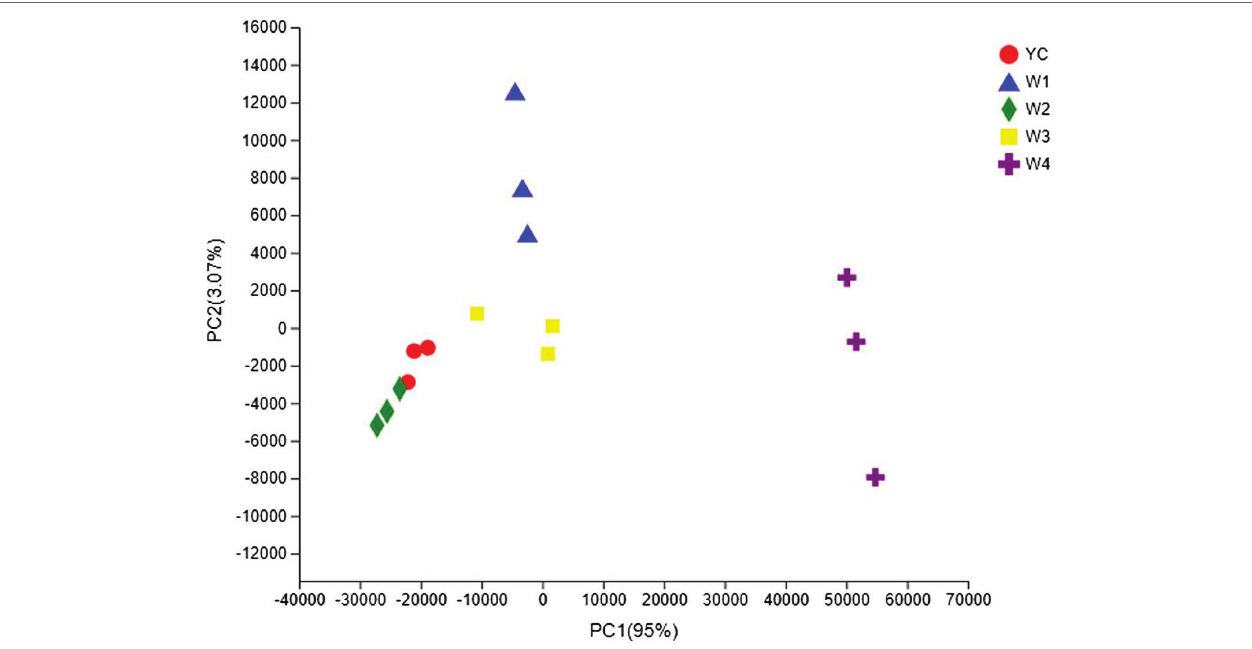
FIGURE 5 | Multiple sample principal component analysis (PCA) of the OTUs. Both selected principal component axes are represented by the x - and y -axes, and the percentage represents the difference in sample composition as determined by the principal component; the scales of the x - and y -axes represent the relative distances. Samples are shown as different color points or shapes in different groups. The closeness of two points or shapes represents the similarity between the species composition of two samples.